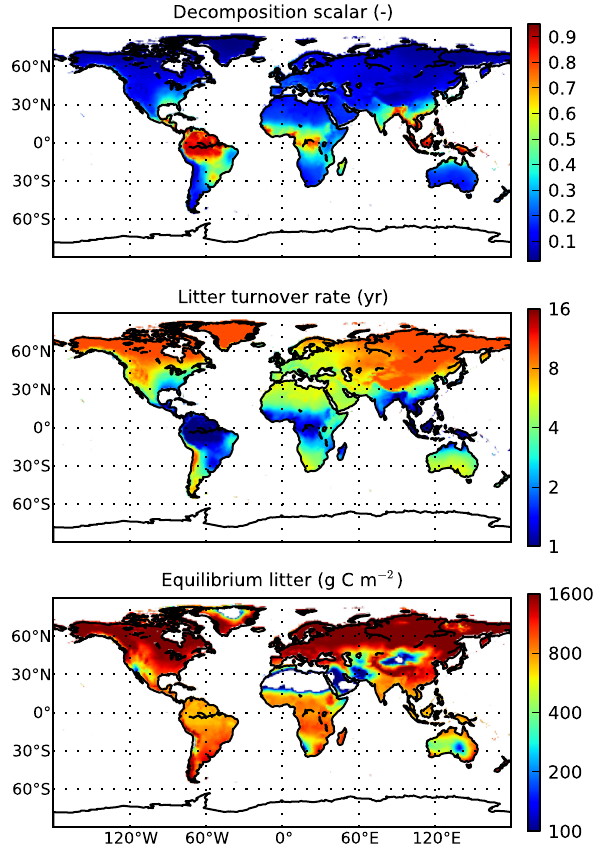
Fig. 5. Decomposition scalars based on a temperature and moisture scalar (top), turnover rates based on the inverse of the decomposi- tion scalar (middle), and equilibrium litter (or fuel) combining NPP and turnover rates (bottom).